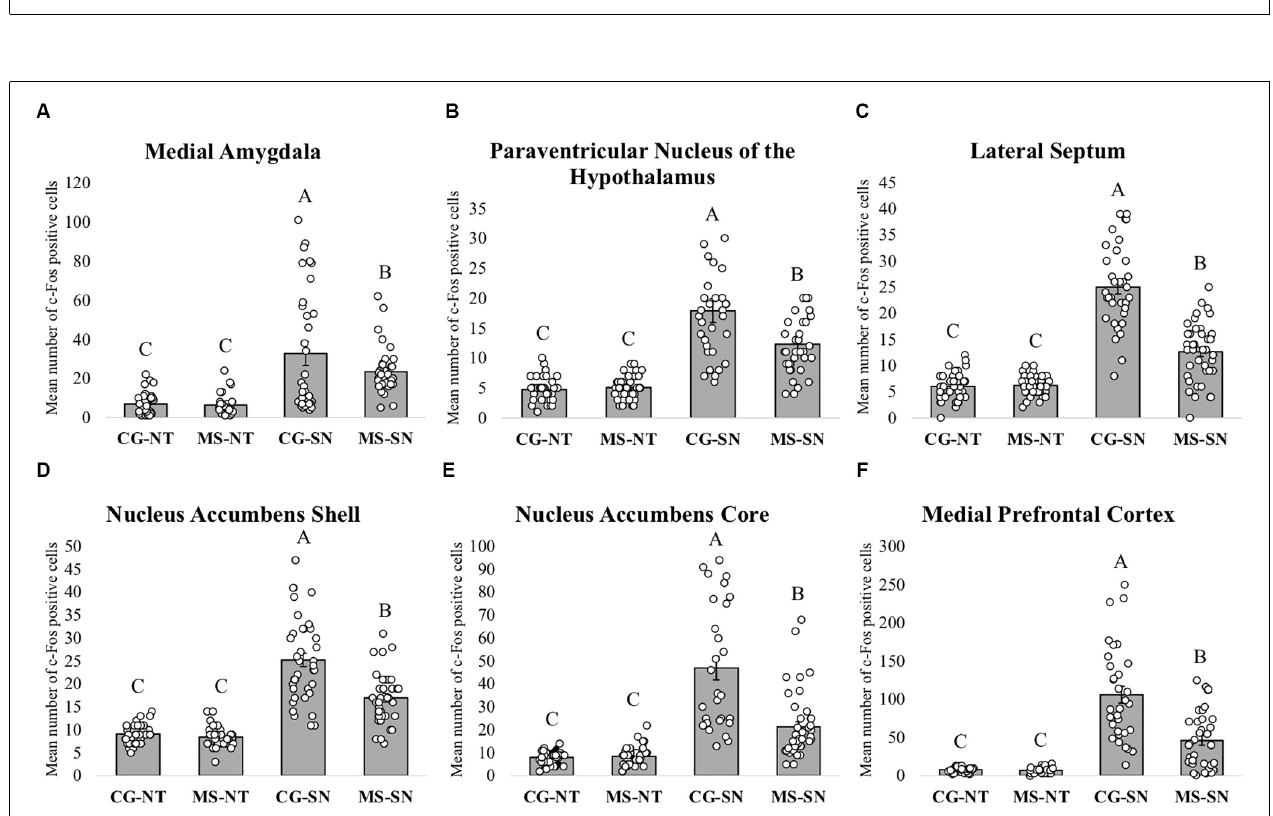
FIGURE 4 | Immunohistochemistry analysis. The graphs show the mean number of c-Fos positive cells in the different groups for each brain area ± SEM. The letters A, B, and C above the bars indicate statistically significant differences between groups in accordance with the post hoc Tuckey tests. c-Fos positive cells were counted using an optic microscope with a 40x objective (64,310 µ m 2 per hemisphere). (A) Mean number of c-Fos positive cells in the Medial Amygdala. (B) Mean number of c-Fos positive cells in the Paraventricular Nucleus of the Hypothalamus. (C) Mean number of c-Fos positive cells in the LS. (D) Mean number of c-Fos positive cells in the Nucleus Accumbens Shell. (E) Mean number of c-Fos positive in the Nucleus Accumbens Core. (F) Mean number of c-Fos positive cells in the medial Prefrontal Cortex. CS-NT, Control Subjects-No Test group; MS-NT, Maternal Separation-No Test group; CS-SN, Control Subjects-Social Novelty Group; MS-SN, Maternal Separation-Social Novelty group. All data are presented as mean ± SEM.